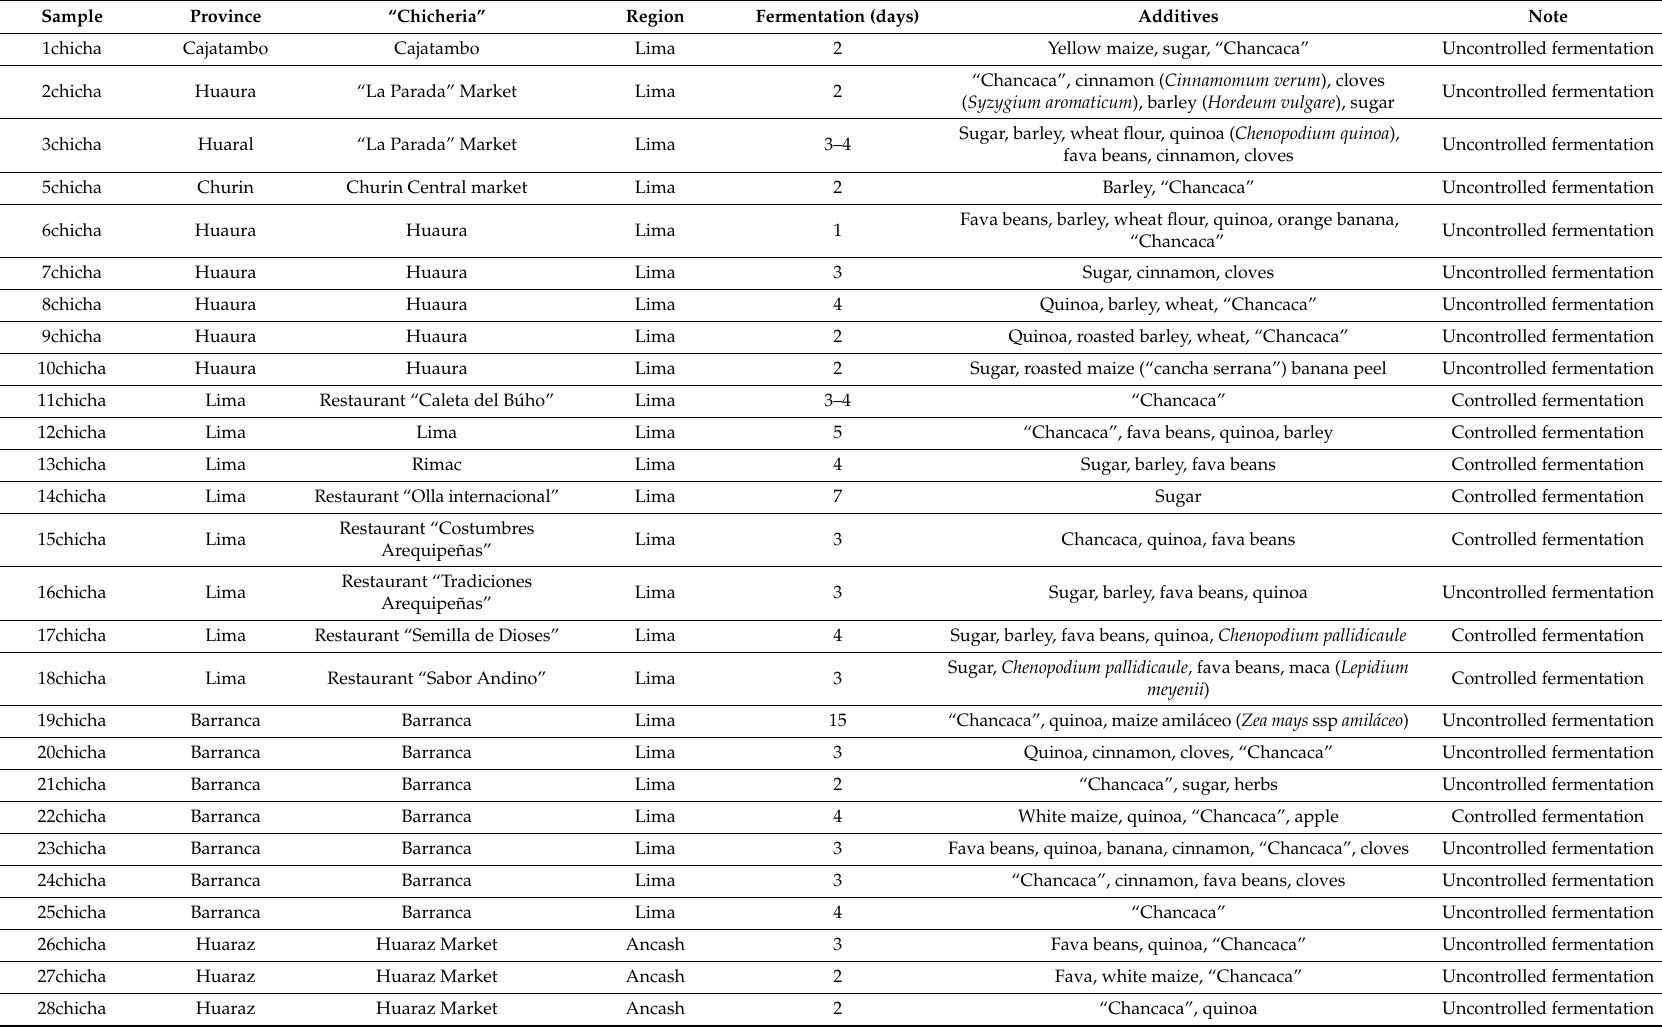
Table 1. Geographical area of production and fermentation features of the 27 chicha